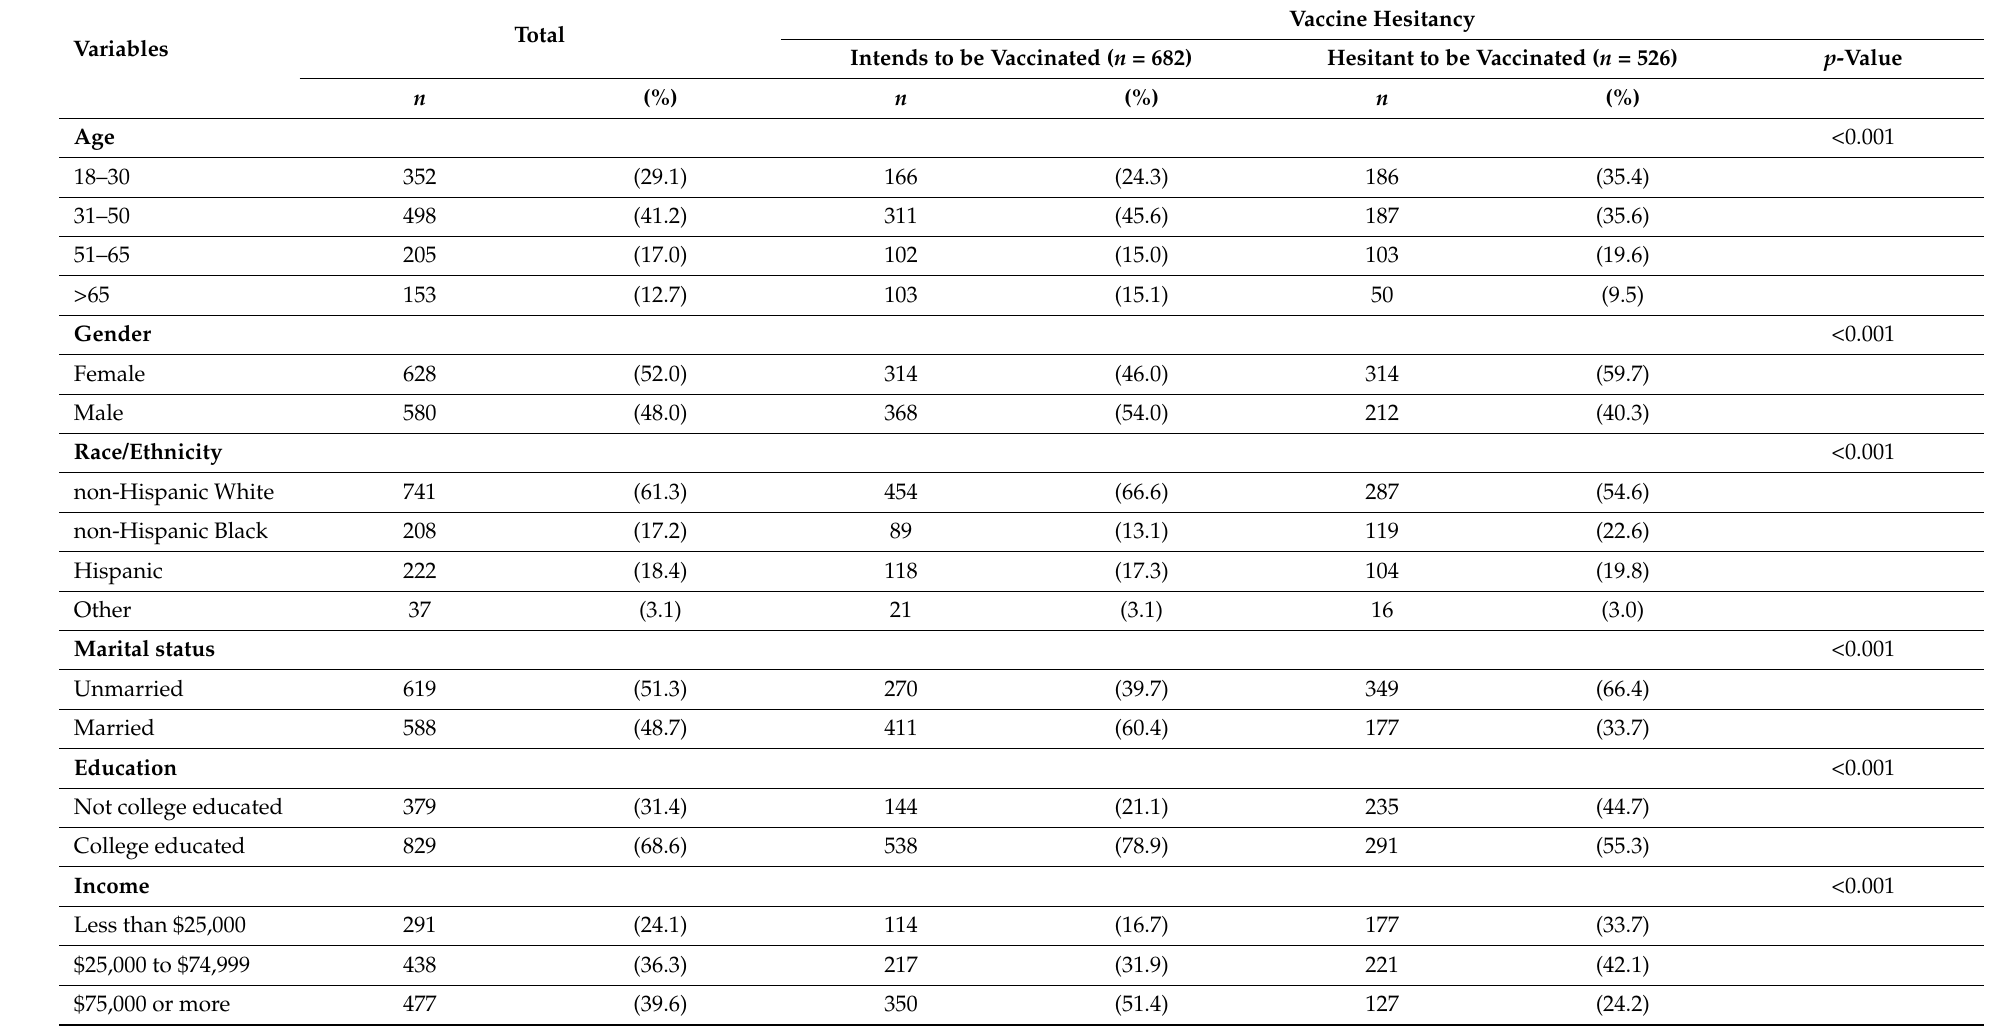
Table 1. Sample characteristics according to vaccine hesitancy